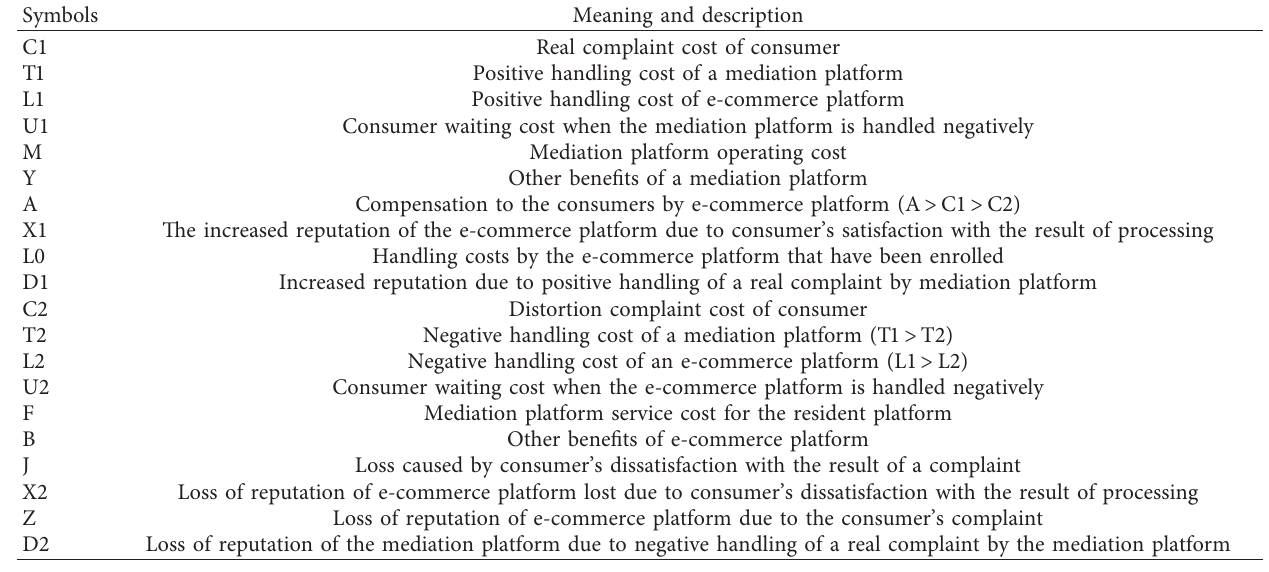
Table 1: Summary of